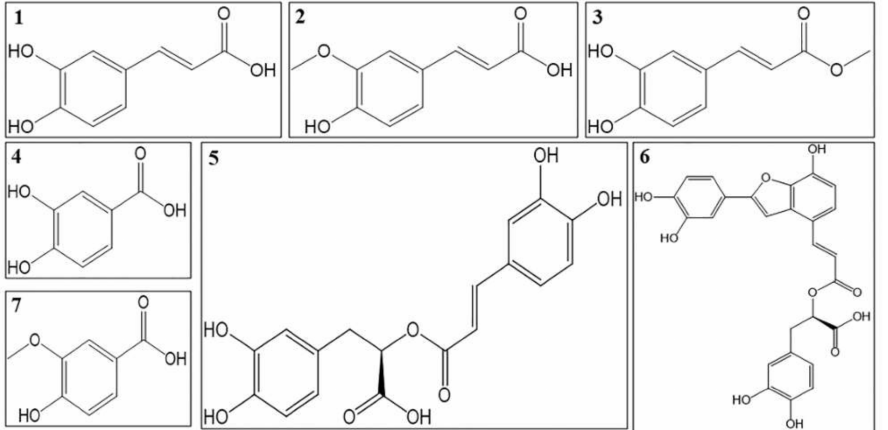
Figure 2. Structures of phenolic acids with antidiabetic effects; ( 1 ) Caffeic acid, ( 2 ) Ferulic acid, ( 3 ) Methyl caffeate, ( 4 ) Protocatechuic acid, ( 5 ) Rosmarinic acid, ( 6 ) Salvianolic acid and ( 7 ) Vanillic acid.